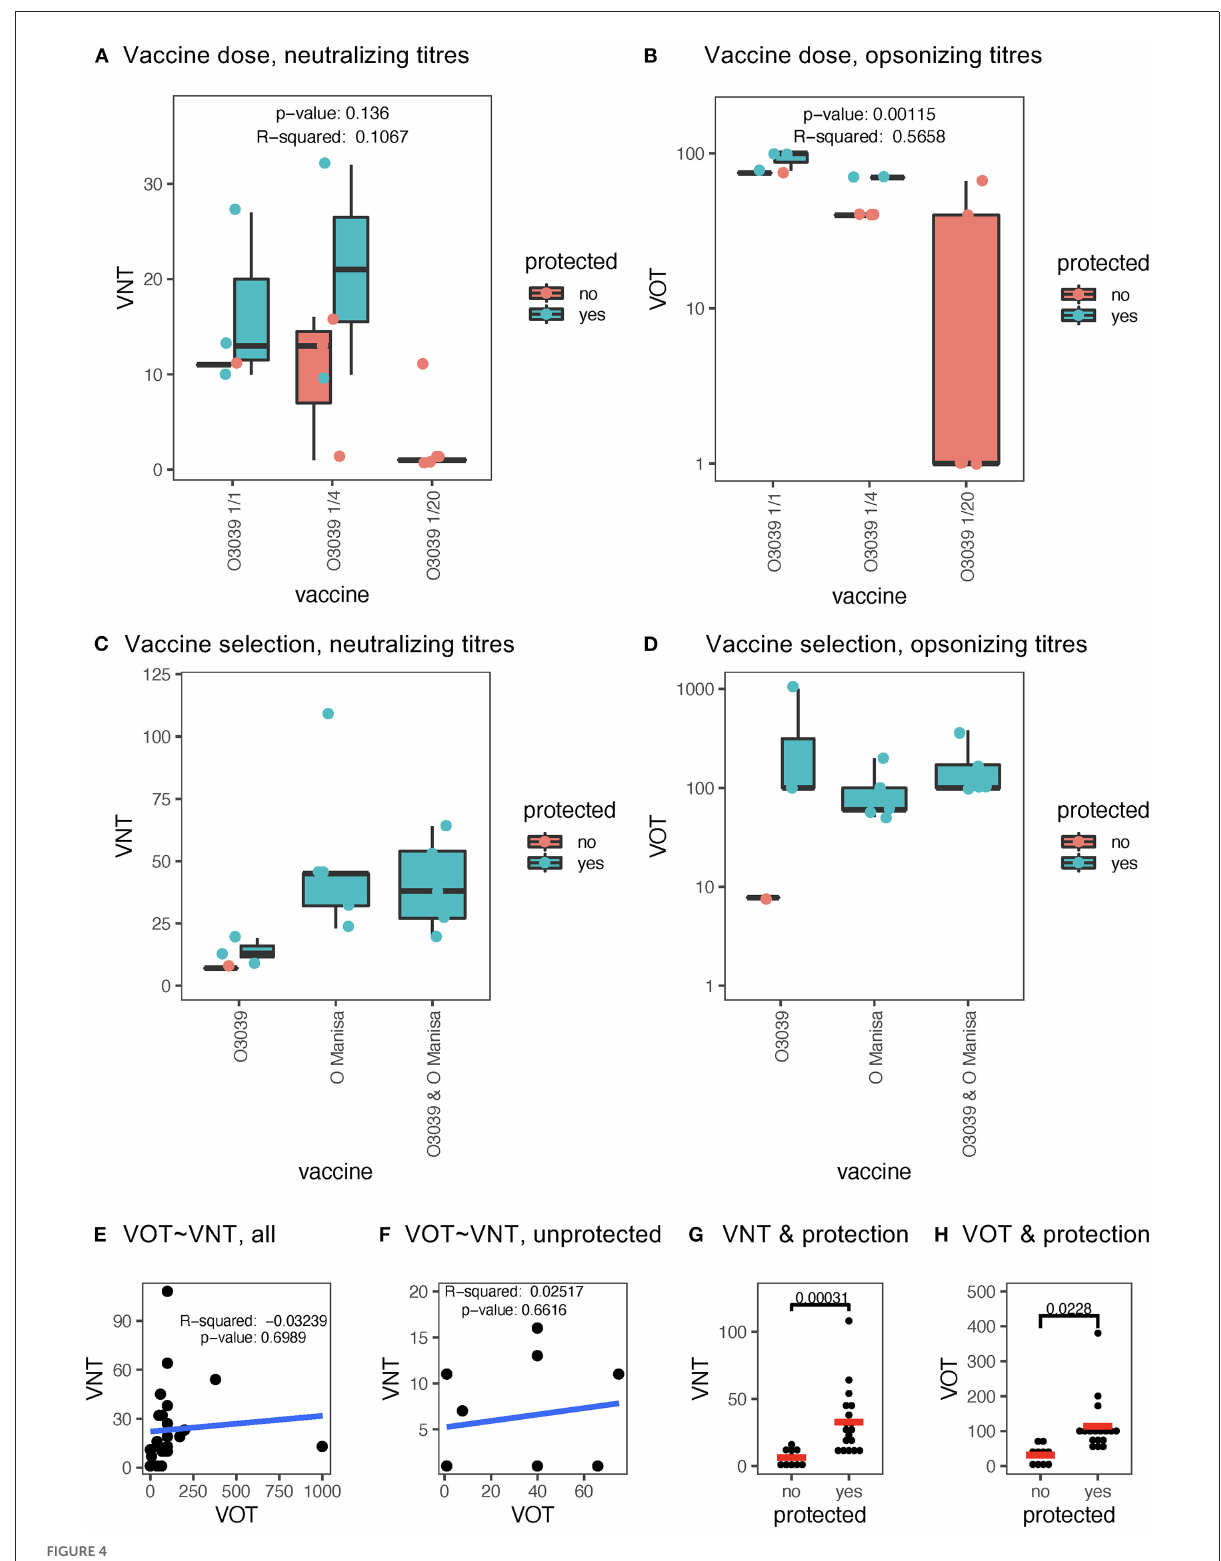
FIGURE4 Relationship of VNT and VOT to vaccine dose, vaccine matching and protection. (A) Shows a boxplot of the VNT of cattle sera collected 21 days post vaccination using a multivalent FMD vaccine (T-1978) at full (:1), quarter (:4), and 1:20 dose (:20). In (B) , the same sera were analyzed for VOT. For the VOT’s the propidium iodide positive values obtained with pre-immune sera at each serum dilution and from the same animal